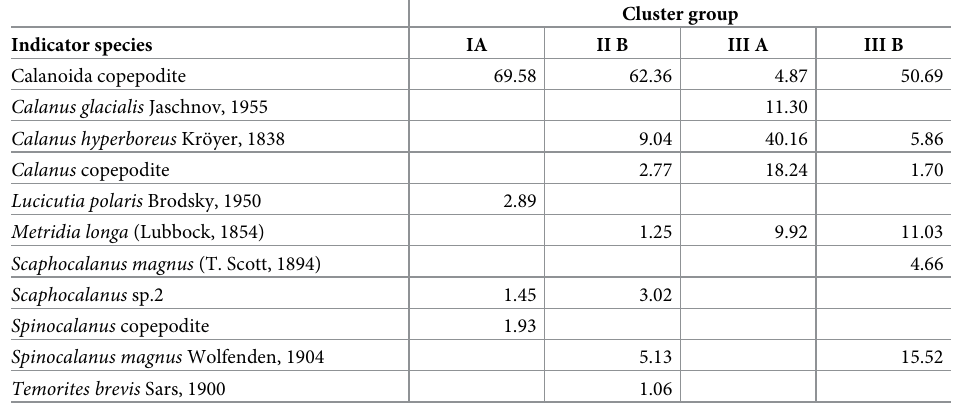
Table 3. Indicator species and index values (%) of each copepod species with a value exceeding 1% for each cluster identified using Bray–Curtis cluster analysis (Fig